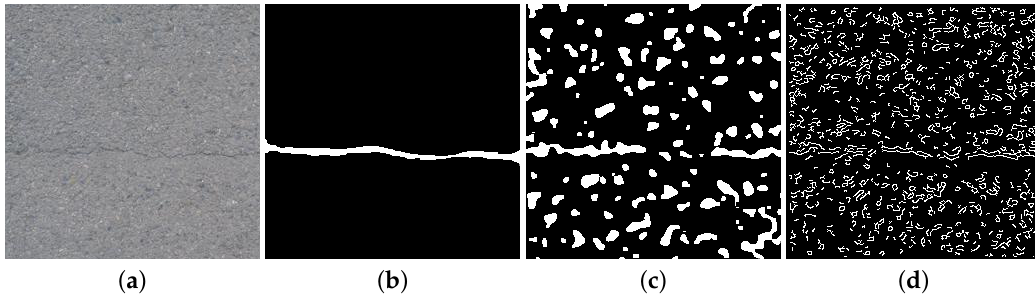
Figure 1. Challenges in crack detection using image processing techniques: Although cracks are edge-like features, they usually represent defects not associated with other edges. ( a ) Original image, ( b ) cracked pixels ground truth, ( c ) sharp transition changes using Difference of Gaussians (DoG), ( d ) Canny edge detection. As it can be seen, edge detection produces other sharp color/contrast transitions along with crack